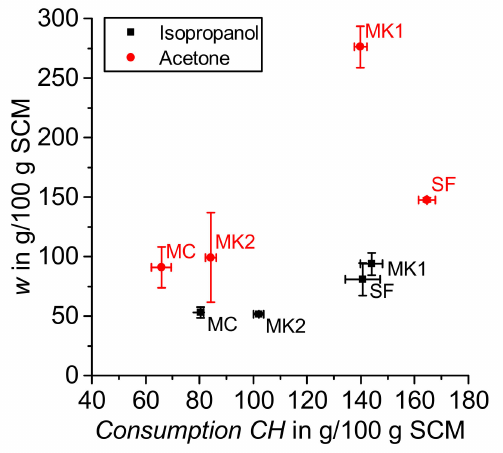
Figure 8. w and Consumption CH (acetone and isopropanol).